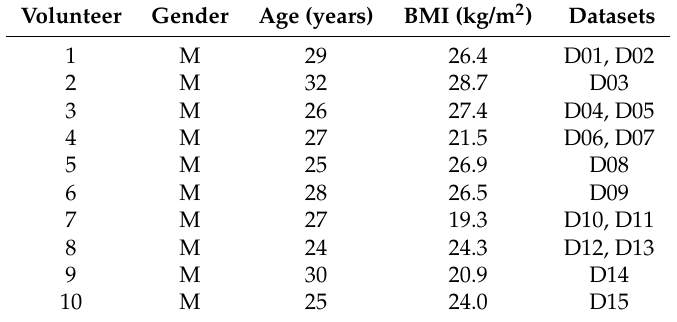
Table 1. Clinical and demographic information of the volunteers who participated in the